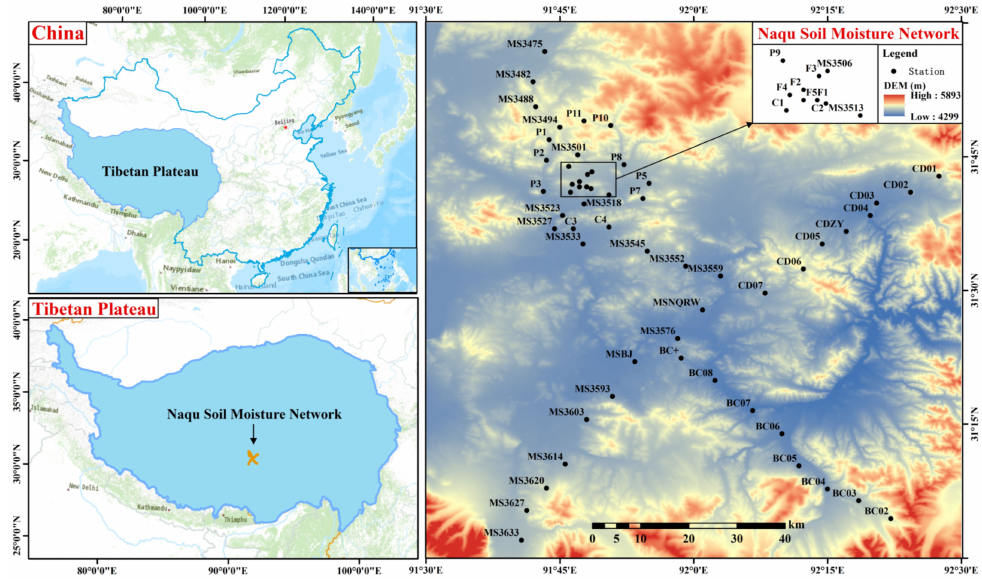
Figure 1. Distribution of CTP-Naqu in situ SM stations. The text above the black dots in the image on the right shows the name of each